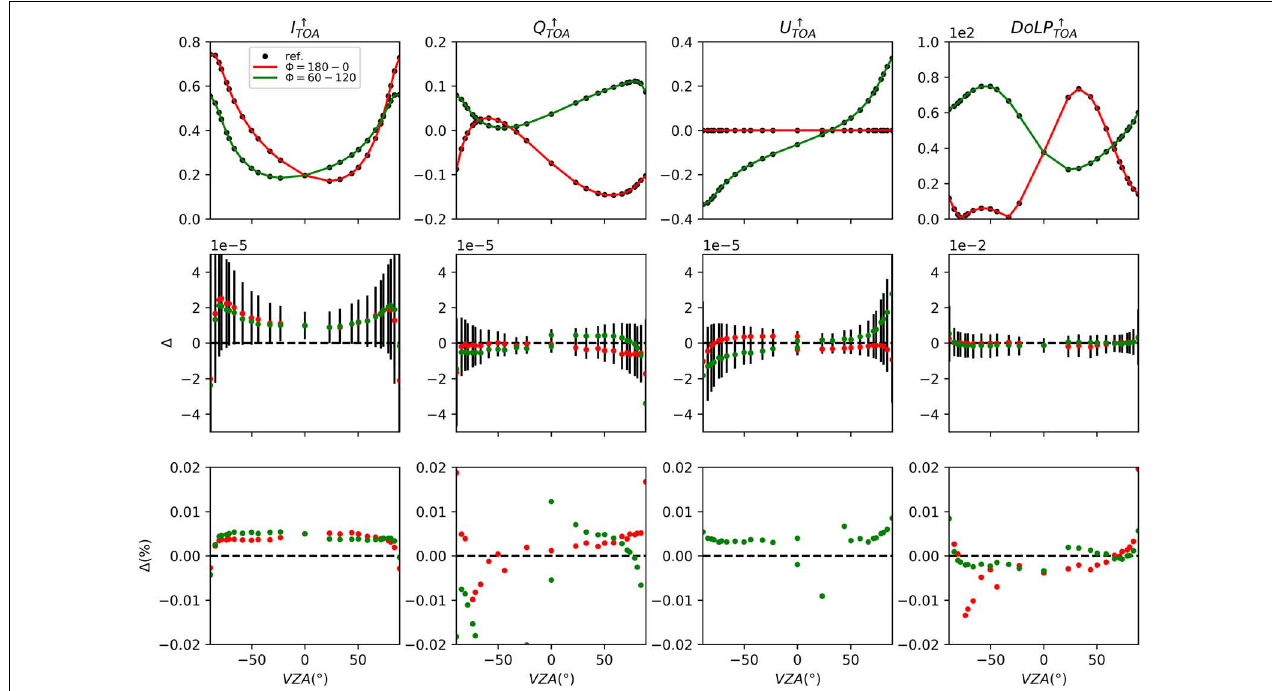
FIGURE 13 | Comparison of benchmark results for AOS-I ∗ model (Chowdhary et al., “Benchmark results for scalar and vector radiative transfer computations of light in atmosphere-ocean systems”, unpublished) computed with the NASA/GISS RT code and the Monte Carlo code (plane-parallel atmosphere) as a function of view angle θ (measured with respect to the surface normal) for relative azimuth angles of 0 ◦ , 60 ◦ , 120 ◦ , and 180 ◦ (red and green curves). Absolute differences are < 0.00002 for the reflectance values of I , Q , and U , and relative differences are generally < 0.02% for